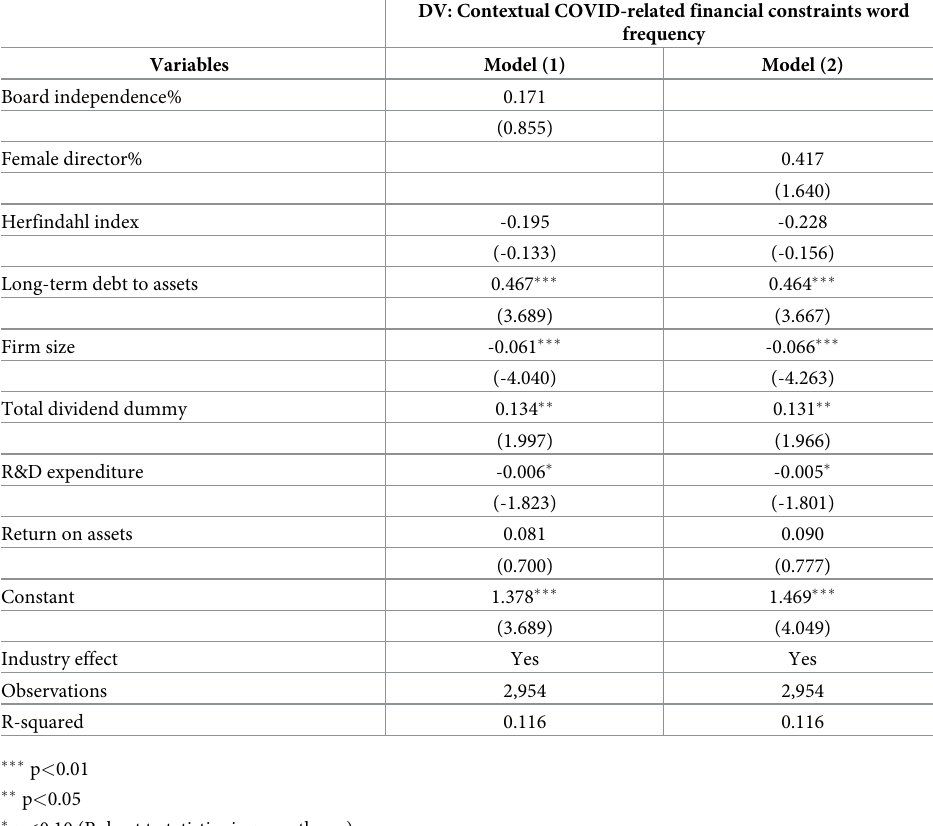
Table 10. Relationship between board-level characteristics and contextual COVID-related financial constraint